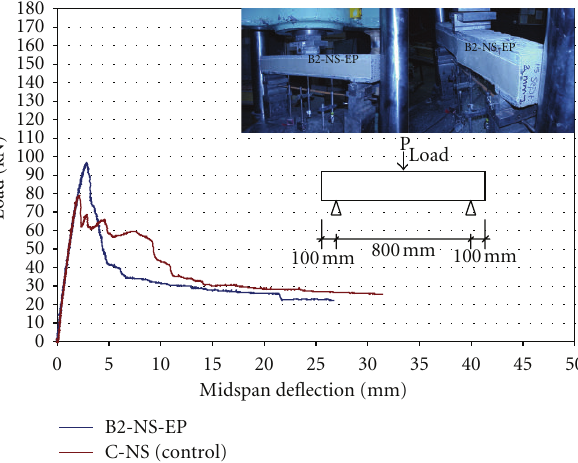
Figure 13: Load versus midspan deflection of RC beam B2-NS-EP.